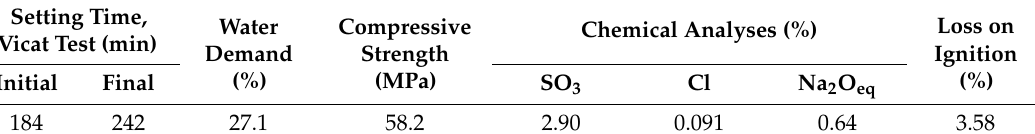
Table 1. The physical and chemical properties of CEM I 42.5R.